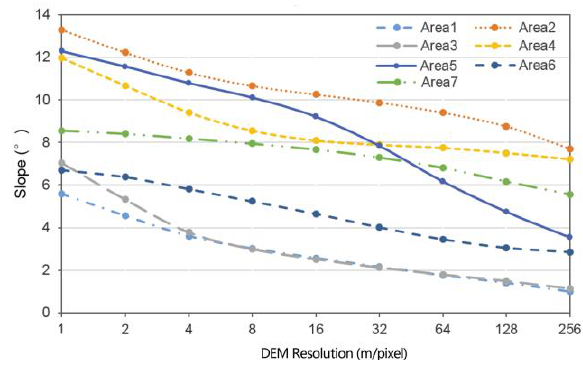
Figure 3. Relationships between average slopes and DEM resolutions for the seven HiRISE